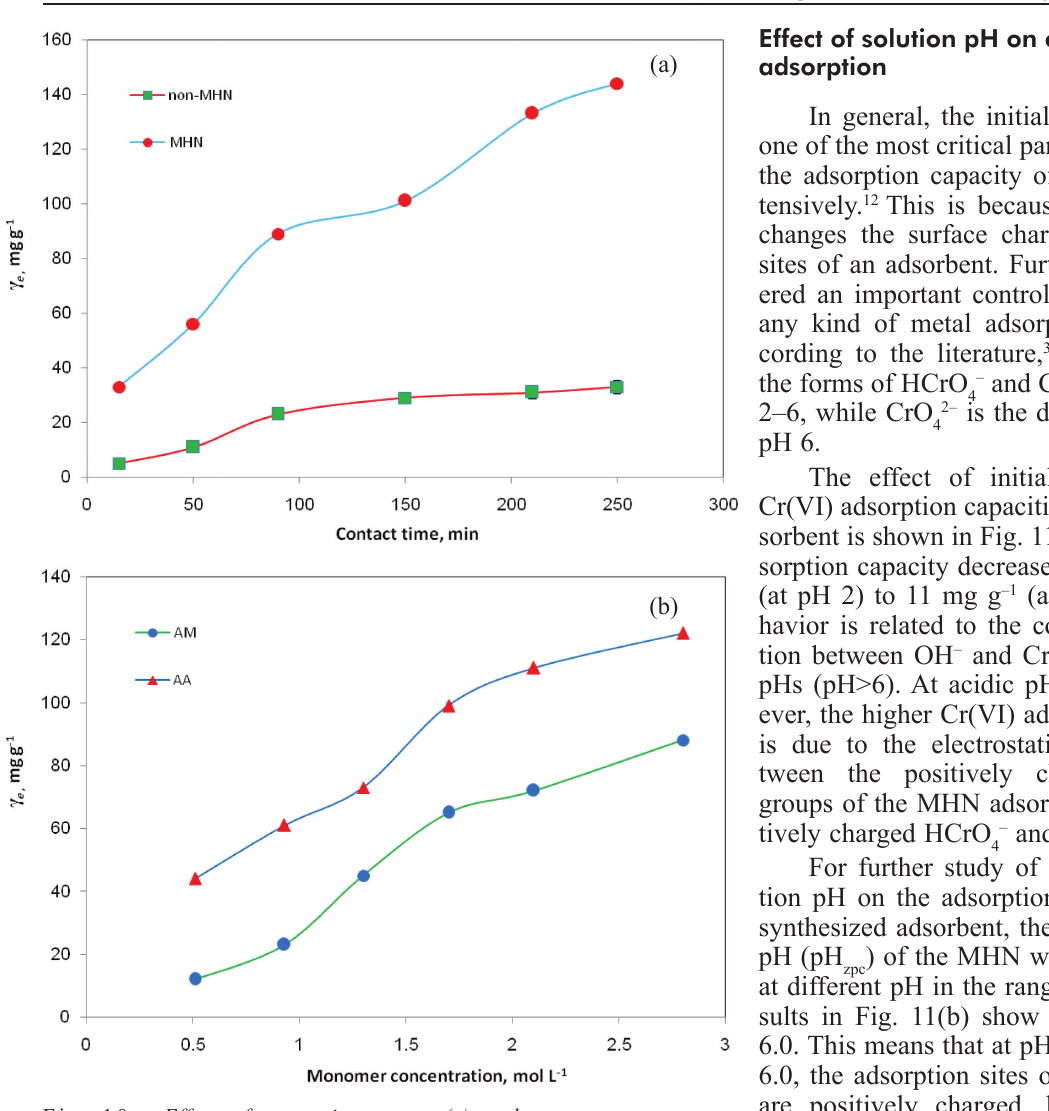
Fig. 10 – Effect of magnetic content (a) and monomer concentrations (b) on Cr(VI) adsorption capacity of MHN